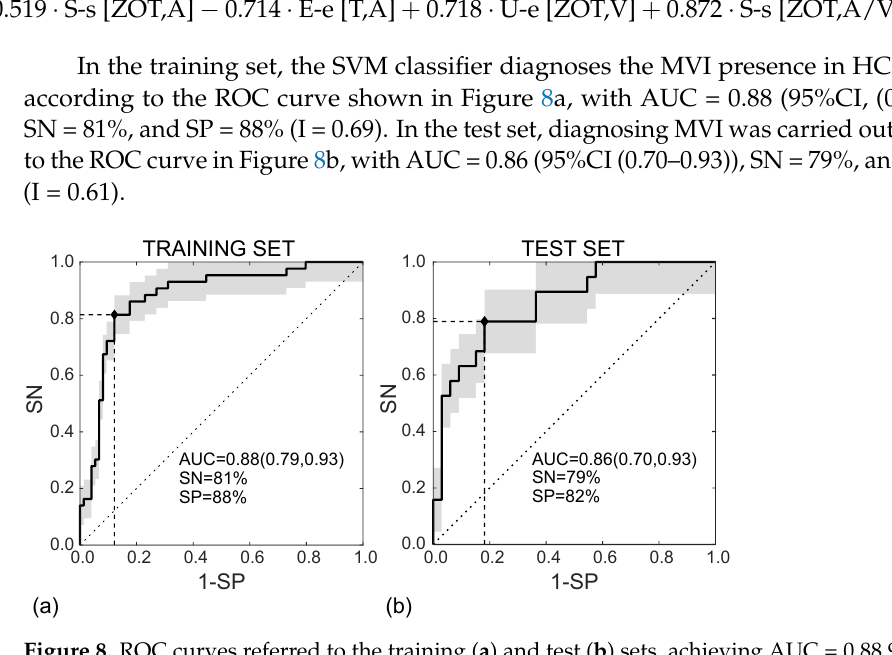
Figure 8. ROC curves referred to the training ( a ) and test ( b ) sets, achieving AUC = 0.88 95%CI (0.79, 0.93) and AUC = 0.86 95%CI (0.70, 0.93),